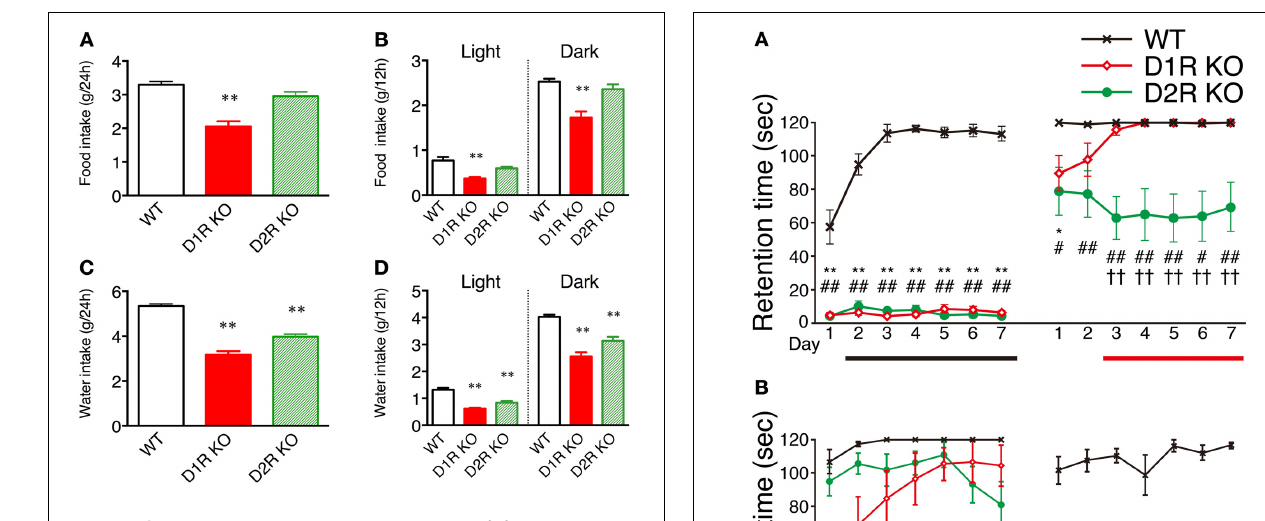
FIGURE 4 | Food and water intakes in home cages. (A) Food intake over 24h or (B) in 12h light and dark phases, and (C) water intake over 24h or (D) in 12h light and dark phases are represented as group mean ± s.e.m. ∗∗ p < 0 . 01 vs. WT (One-Way ANOVA, Tukey’s test).